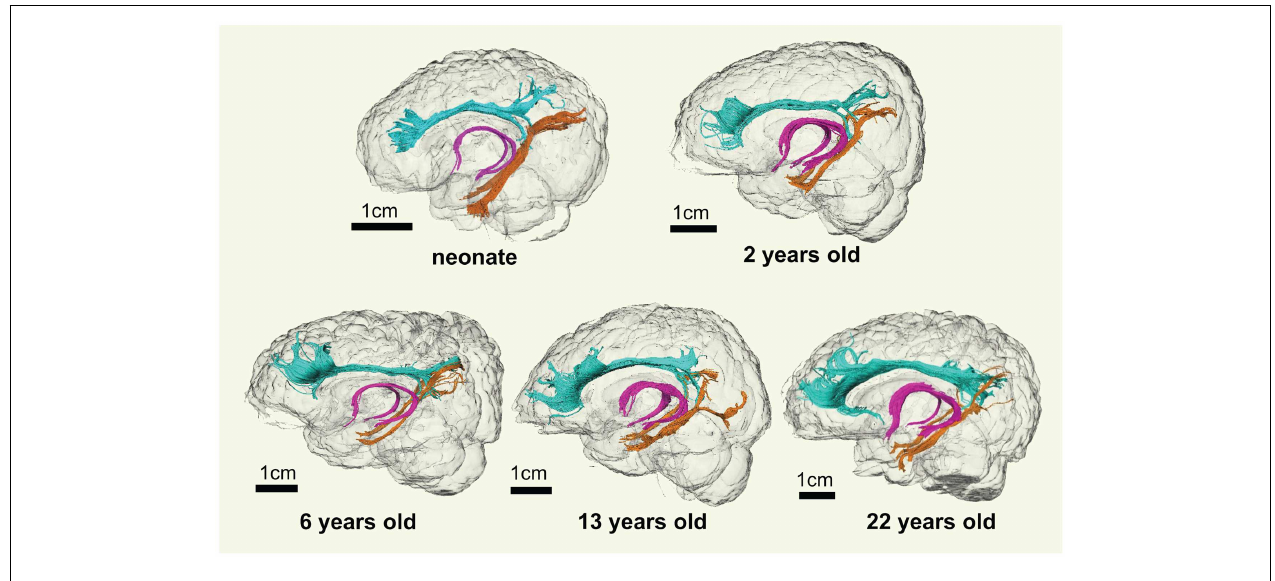
FIGURE 2 | 3D visualization of the traced limbic tracts of representative subjects at following developing stages, at birth (0month), early childhood (2years old), childhood (6years old), adolescence (13years